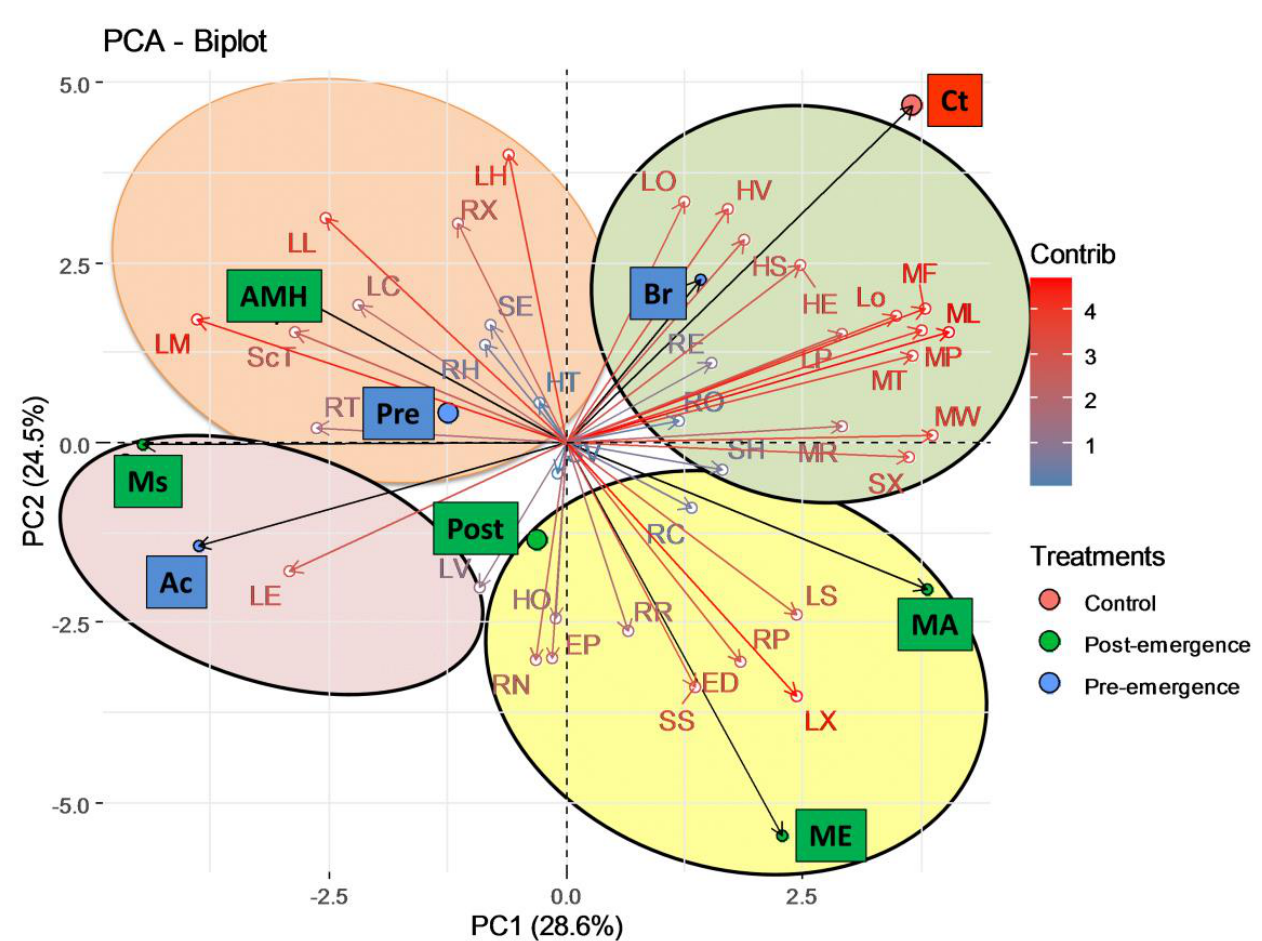
Figure 8. Principal component analysis representing relationship of various morphological and anatomical characteristics of Dactyloctenium aegyptium . The eclipses are drawn to group parameters on the basis of herbicides and mode of application. Red color indicates control group, blue show pre-emergence and green is used for post-emergence herbicides. For abbreviations please see list at the end of